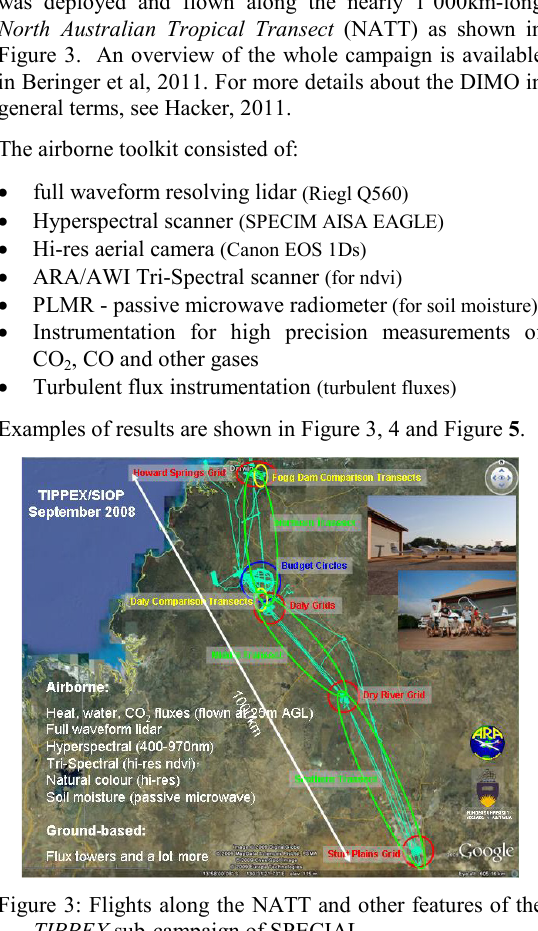
Figure 3. An overview of the whole campaign is available in Beringer et al, 2011. For more details about the DIMO in general terms, see Hacker, 2011.